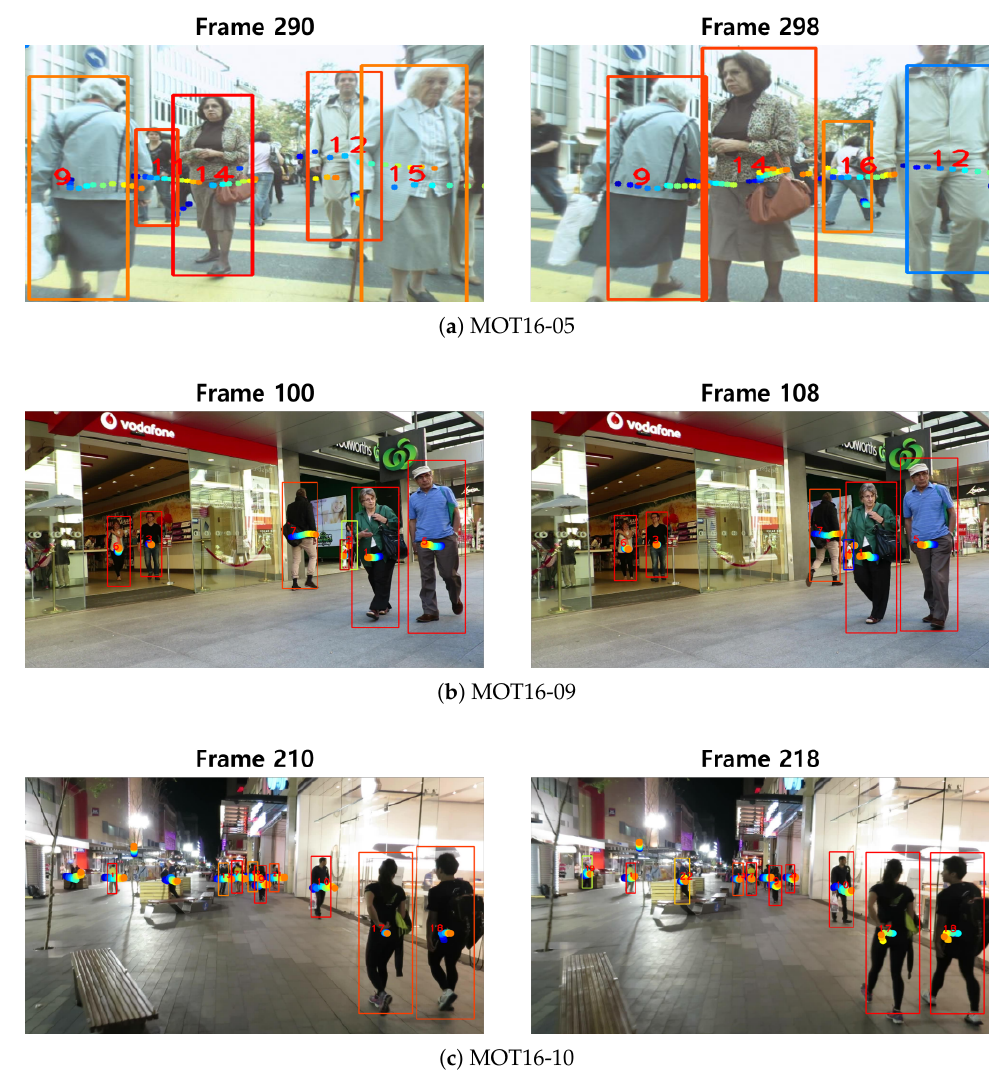
Figure 10. Predicted object motion trajectories on several sequences. At current frame t , the predicted motions from t + 1 (blue) to t + ∆ est (orange) are depicted with different dot colors on each